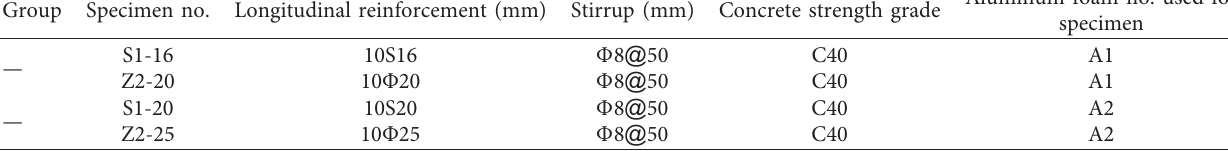
Table 1: Design parameters of specimen for